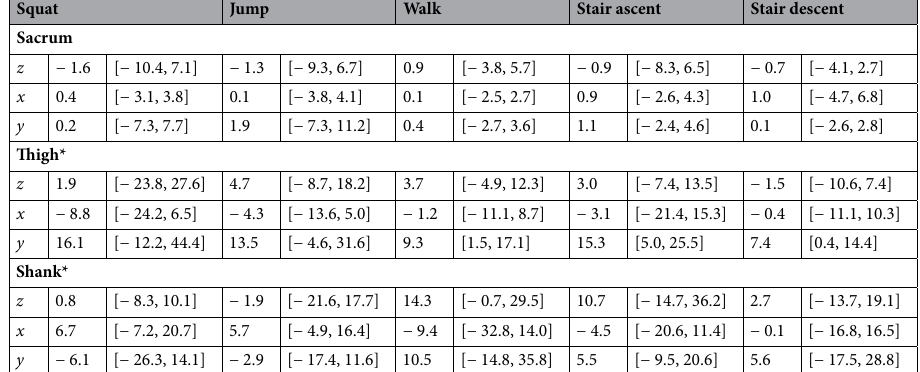
Table 2. Mean differences [95% CIs] for orientation range data between Xsens MTw and Xsens Dot. CI confidence interval. *Data presented for right limb.